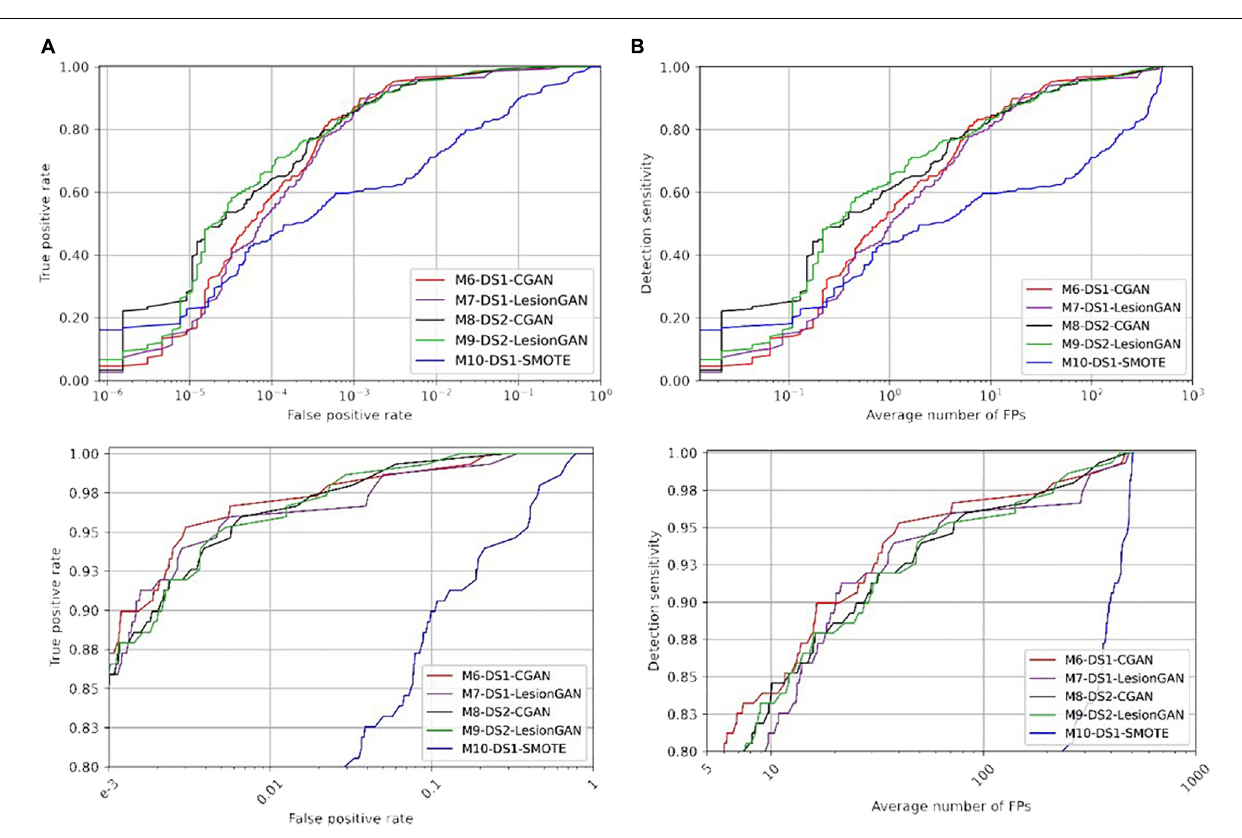
lesion) for training. The proposed synthetic data generation model compared favorably to other data augmentation